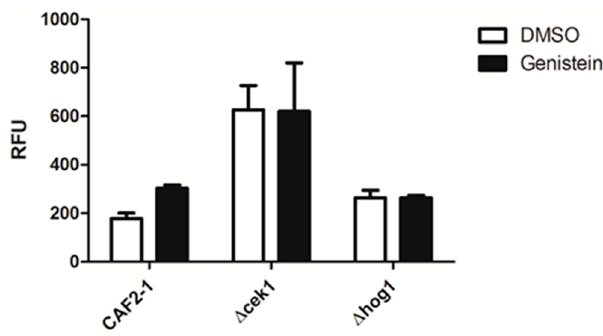
Figure 3. Phagocytosis of genistein treated mutants by RAW 264.7 macrophages in comparison to the reference strain treated CAF2-1. The phagocytosis time was 45 min. RFU: relative fluorescence units.